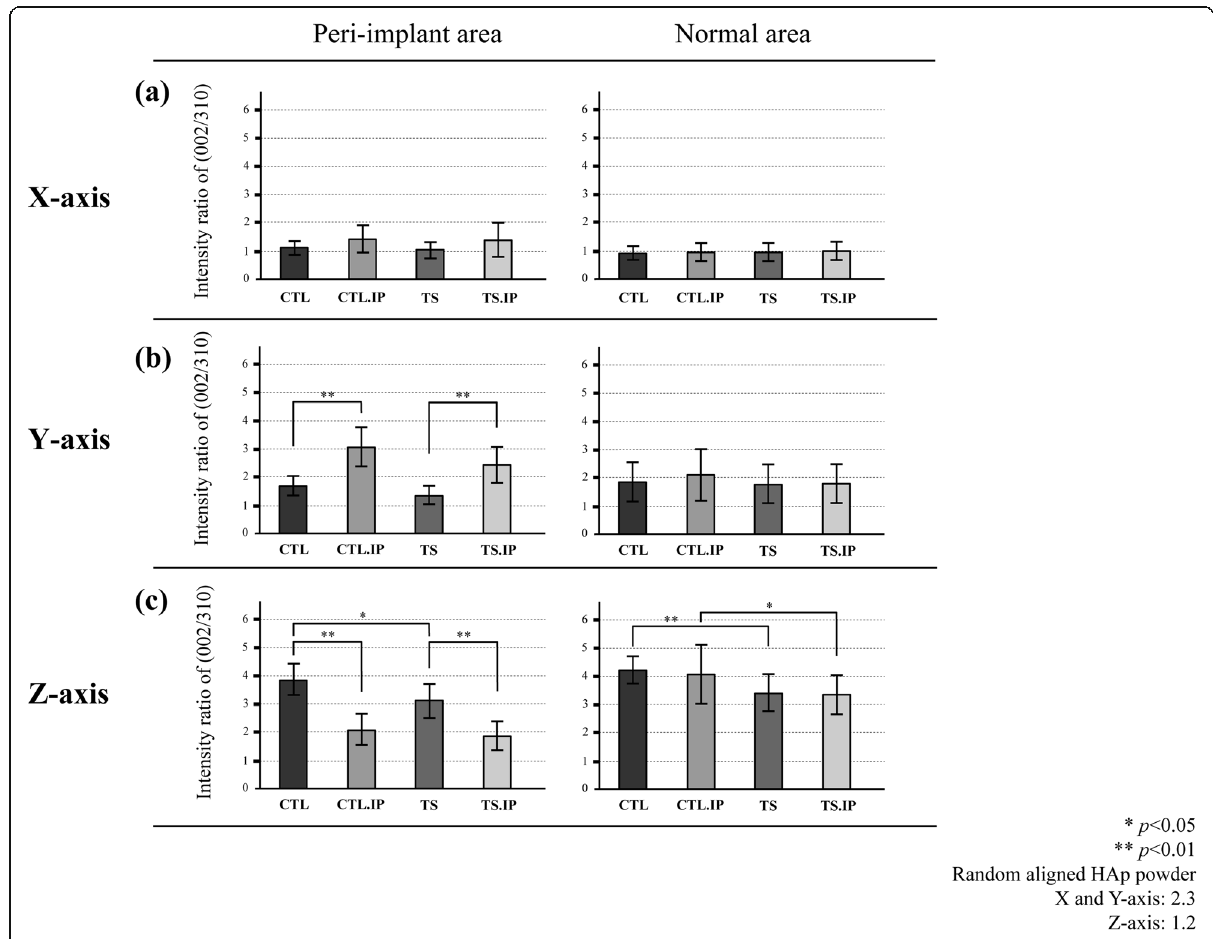
Fig. 10 Orientation of BAp c-axis in each measurement axis. The vertical axis shows the X-ray diffraction intensity ratio calculated from the (002)/ (310) peaks, and the horizontal axis shows the groups. a X -axis (antero-posterior) direction. b Y -axis (mesio-lateral) direction. c Z -axis (femoral long-axis)